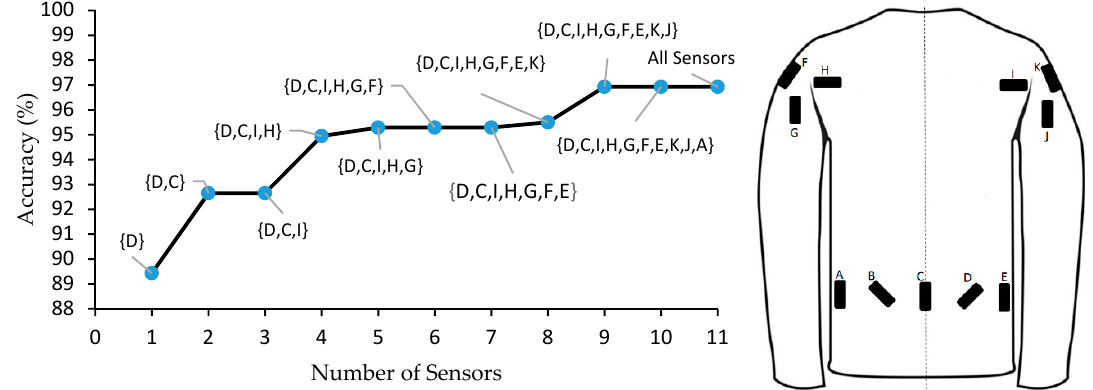
Figure 3. Results of applying the Bayes accuracy method (left) to identify effective subsets of sensors, from the total of 11 sensors in the SUS (sensors are labeled in the figure on the right, using letters A-K).